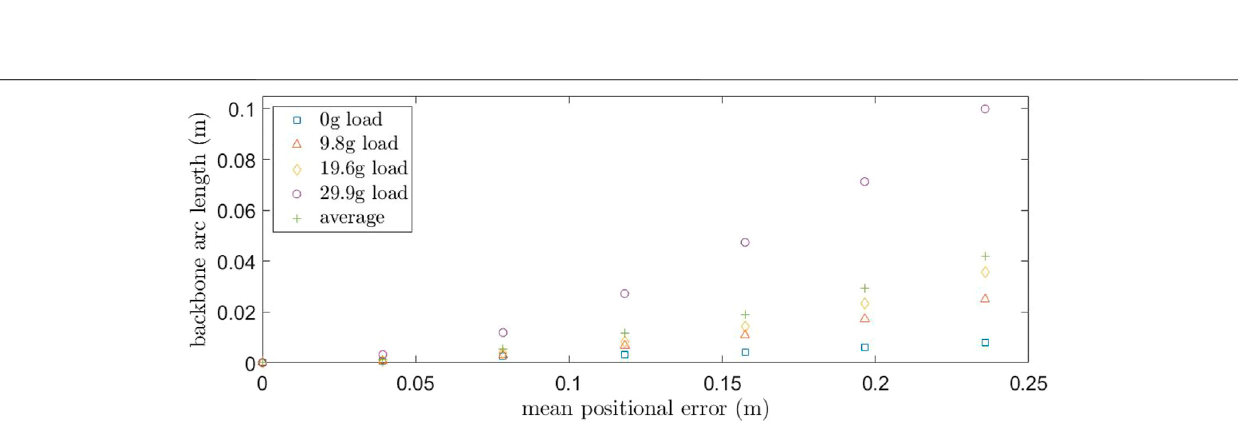
FIGURE 12 | Mean positional error for different OptiTrack sensor backbone locations for increasing end load; 0, 96.14, 189.92, 293.32